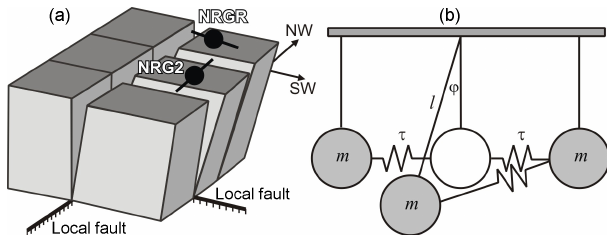
Figure 4. The generalized model of block movement in the verti- cal plane along differently oriented local faults of the hinge type due to variable vertical loading. (a) The model of block movement along NE- and NW-trending faults and schemes of the full dis- placement vector decomposition into components. (b) The model of block movement in the shape of coupled pendulums (notations are given in the